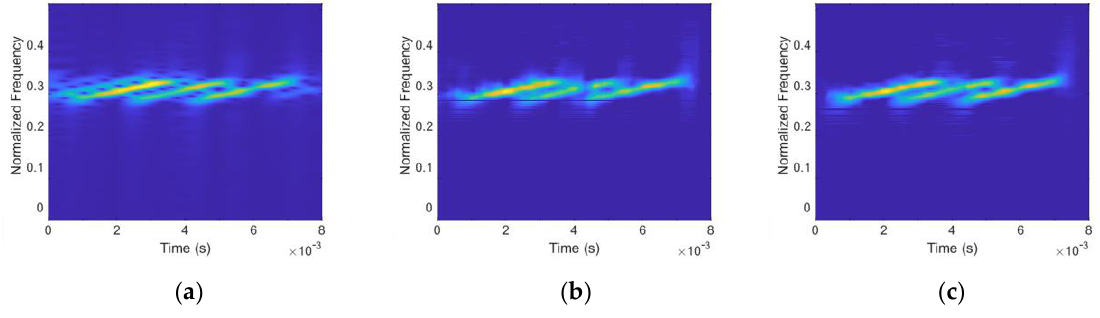
Figure 5. Reverberation suppression results: ( a ) input signal; ( b ) output of the proposed ACANet without SAM; ( c ) output of the proposed ACANet.